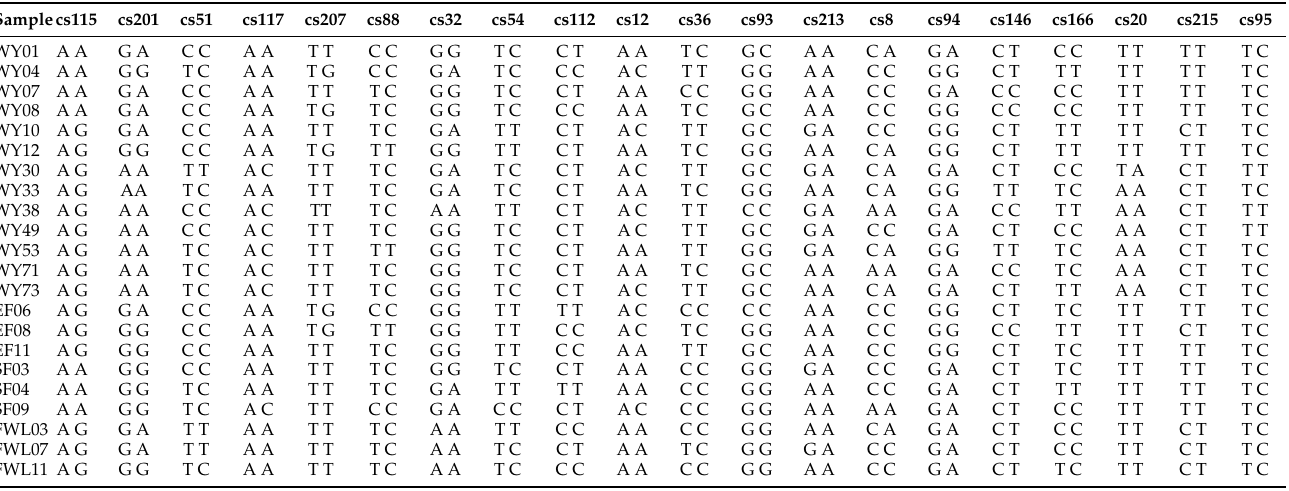
Table 3. Genotypic DNA fingerprinting of tea germplasms based on SNP arrays (showing truncated spectra of 20 loci of 22